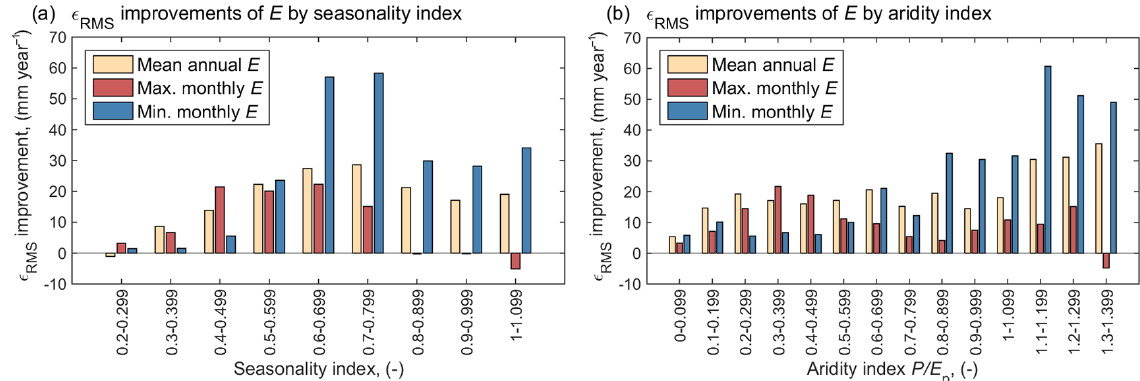
Figure 7. The improvement in root mean square error ( ε RMS ) in simulated mean monthly evaporation E by implementing S R,CRU-SM (estimated based on E SM and P CRU in this study) instead S R,STEAM (based on look-up table in Wang-Erlandsson et al., 2014) in the global hydrological model STEAM. The improvements in mean annual, mean maximum monthly and mean minimum monthly E (over the years 2003–2013) are sorted by (a) precipitation seasonality index and (b) aridity index (defined in Appendix B1). The satellite-based ensemble evaporation based on SSEBop and MOD16 ( E SM ) was used as the benchmark for improvements (see methods described in Sect. 2.2). Only bins containing a minimum of 200 grid cells are shown.